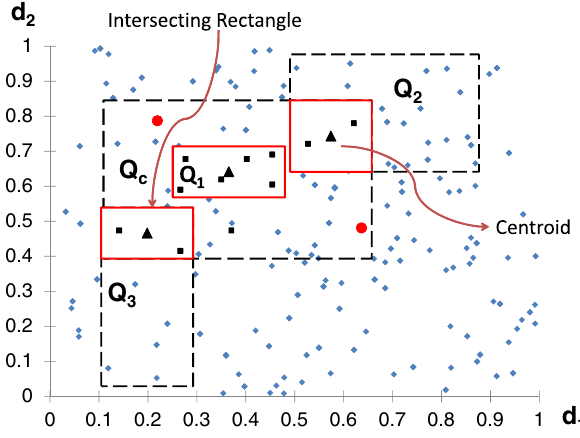
Fig. 7 Ordering of overlapping cached diverse results